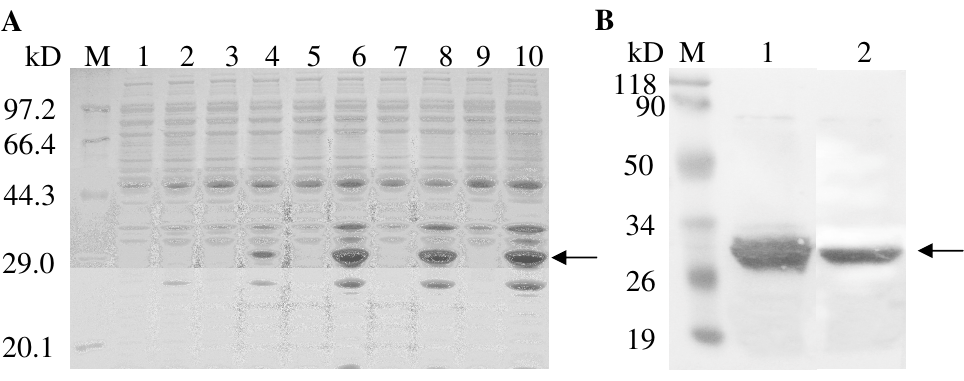
Figure 3. Expression and analysis of the recombinant His -tagged mTaHO1 protein in E. coli . ( A ) Expressed proteins were induced with IPTG, 30 µ g protein/well. Lane M, Marker proteins; lane 1, protein from IPTG-induced bacteria for 12 h harboring pET-28a(+) alone as control; lane 2,3,5,7, and 9, proteins from uninduced bacteria for 0, 1, 3, 6 and 12 h, respectively; lane 4,6,8 and 10, proteins from IPTG-induced bacteria for 1, 3, 6 and 12 h, respectively; ( B ) Expressed protein purified by Ni-affinity chromatography and its gel blot analysis, 60 µ g protein/well. Lane M, Marker proteins; lane 1, purified protein; lane 2, immunoblot of purified protein developed with the polyclonal antiserum against the mature wheat HO-1 (mTaHO1) with a molecular mass of 31